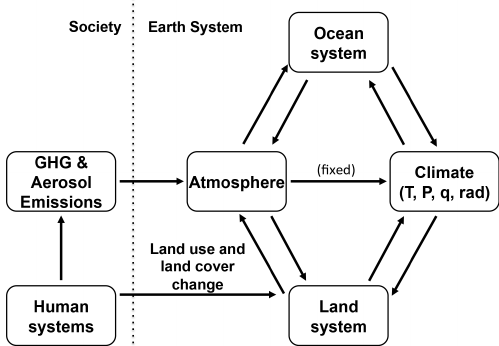
Figure 1. Illustration of the one-way coupling from the human to the climate system used in prior simulations of global environmen- tal